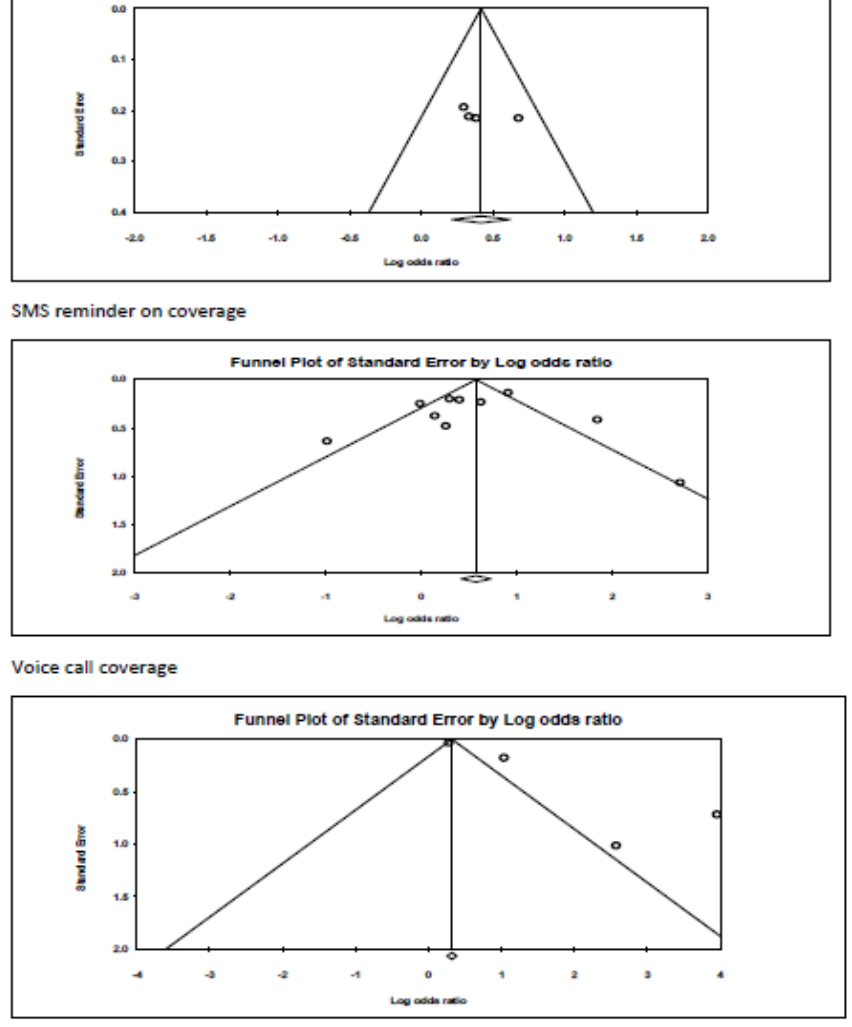
Figure A1. Funnel plots on coverage .